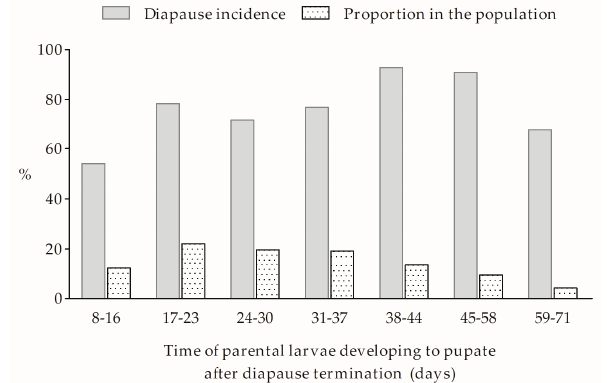
Figure 1. Variations in diapause and voltinism derived from the HH population of ACB. The parental larvae population is grouped according to the variation in larval development (x-axis; in days) from diapause termination to pupation. The diapause incidence rate (gray bars) and the proportion of populational univoltism (bars with dots) in offspring were summarized for each parental group.